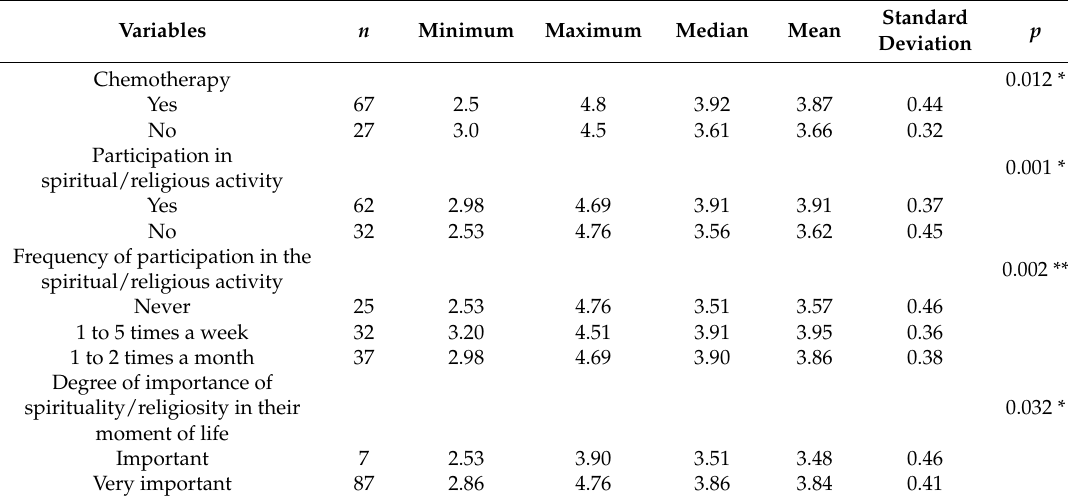
Table 2. Distribution of the participants of a rehabilitation center for mastectomized women, according to the comparison of Total SRC with the statistically significant variables. Ribeir ã o Preto, SP, Brazil, 2013–2014 ( n = 94).